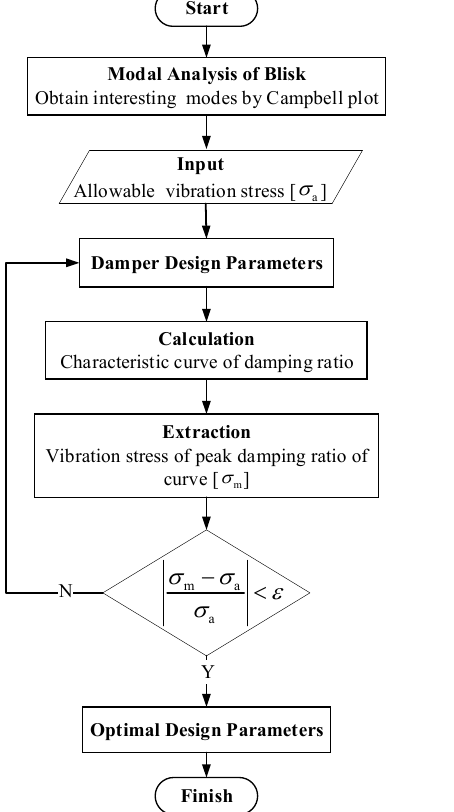
Figure 11. Damping characteristic curve.